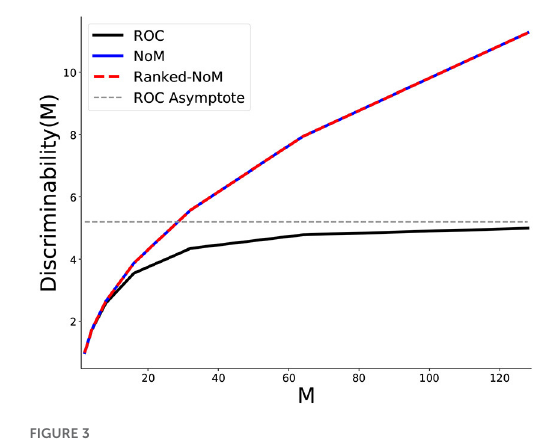
FIGURE3 Behavior of the maximal discriminability as a function of the total number of inputs M . NoM and Ranked-NoM (set to M / 2) converge to the same maximal values and so W N = = the two curves overlap. For these two schemes, the maximal